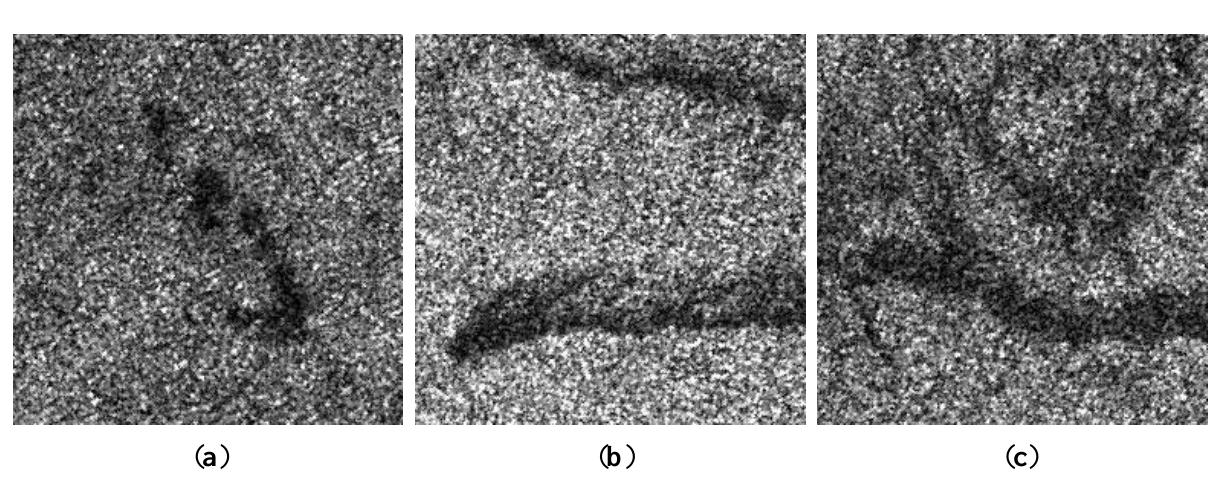
Figure 7. Real 4-looks SAR intensity images in which the dark areas are oil